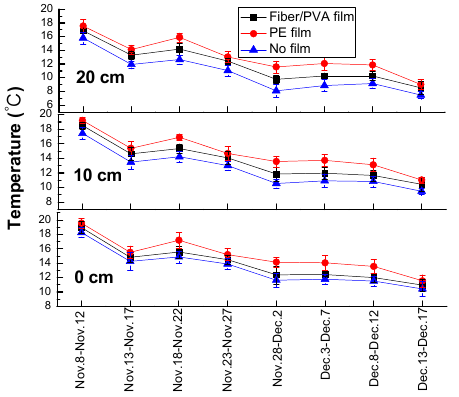
Figure 1. Temperatures measured under soil (at depths of 0, 10, and 20 cm) covered by different mulching films (fiber/PVA and PE) and no film.